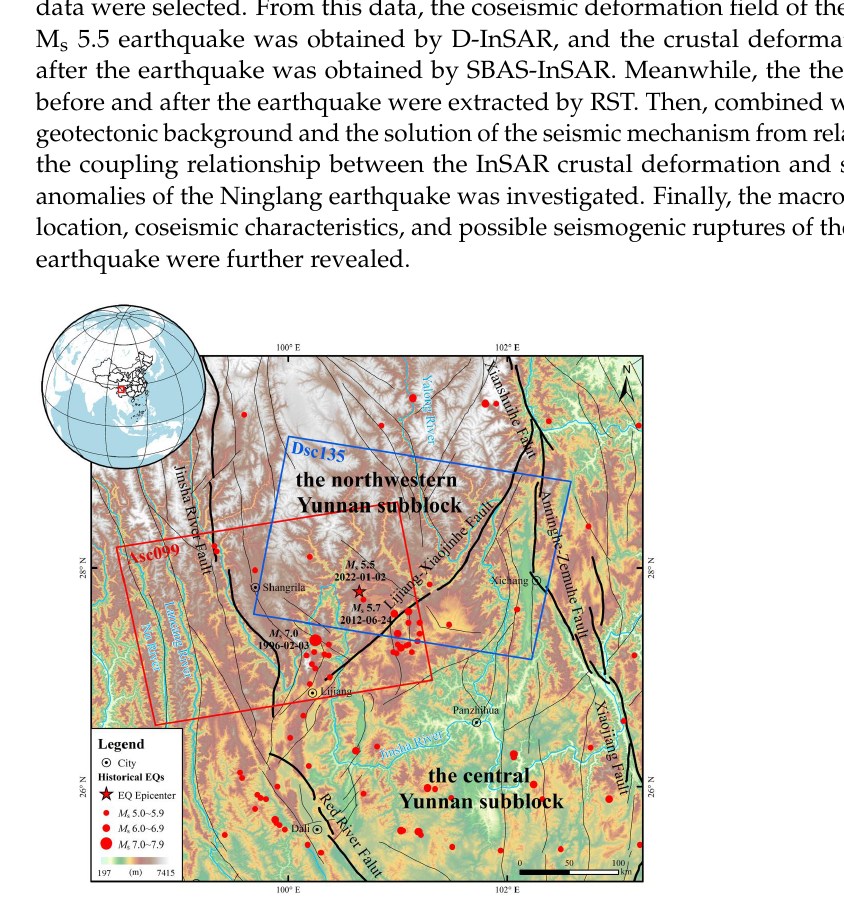
1 The focal mechanism solution and the optimal moment center source depth for the inversion using the cut- and-paste (CAP) method based on body and surface waveforms; 2 The solution of the P-wave initial motion source mechanism.